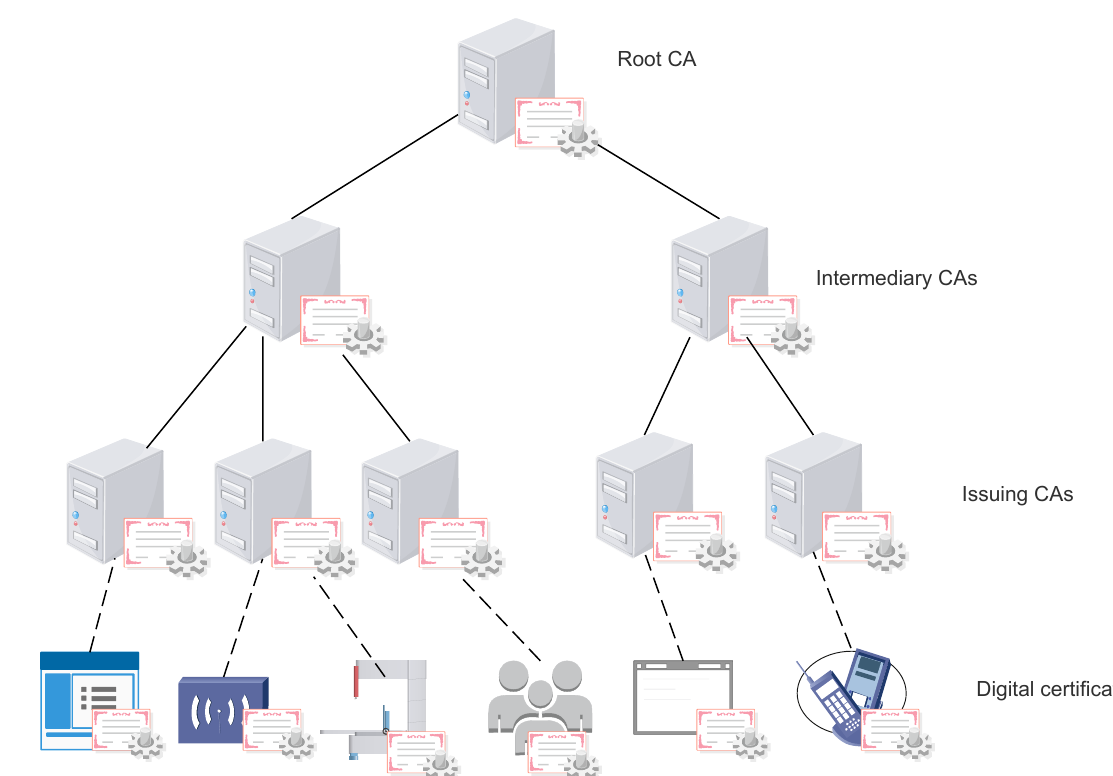
Figure 1. Traditional Certification Authority